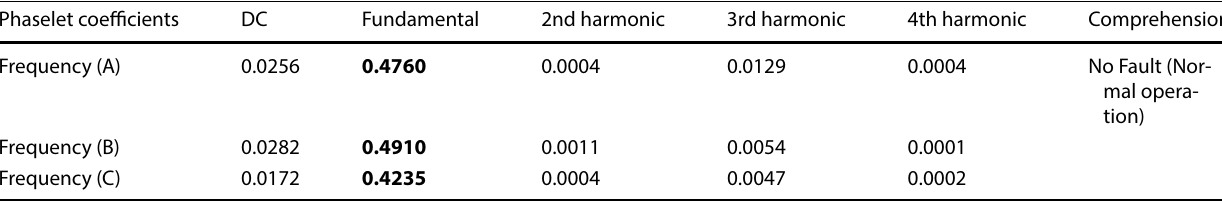
Table 1 Phaselet coefficients for normal operation